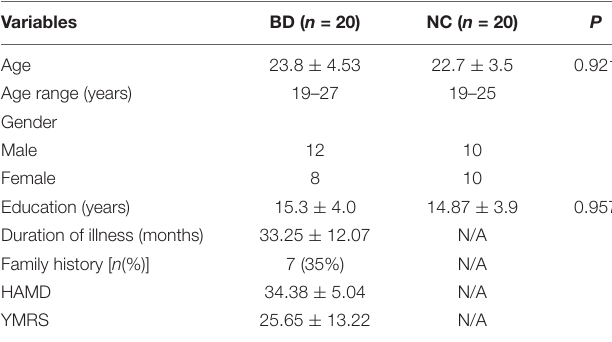
TABLE 1 | Basic clinical data of BD and normal